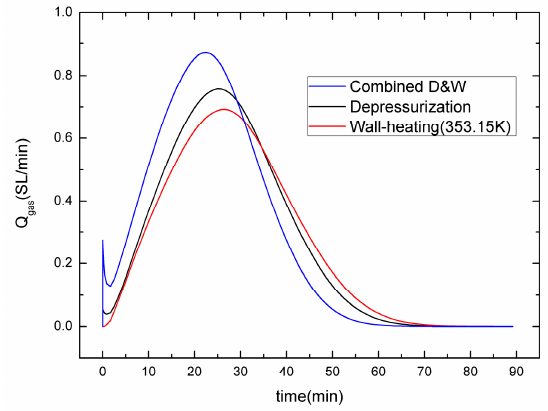
Figure 5. Gas generation rate during hydrate dissociation induced by different production methods.